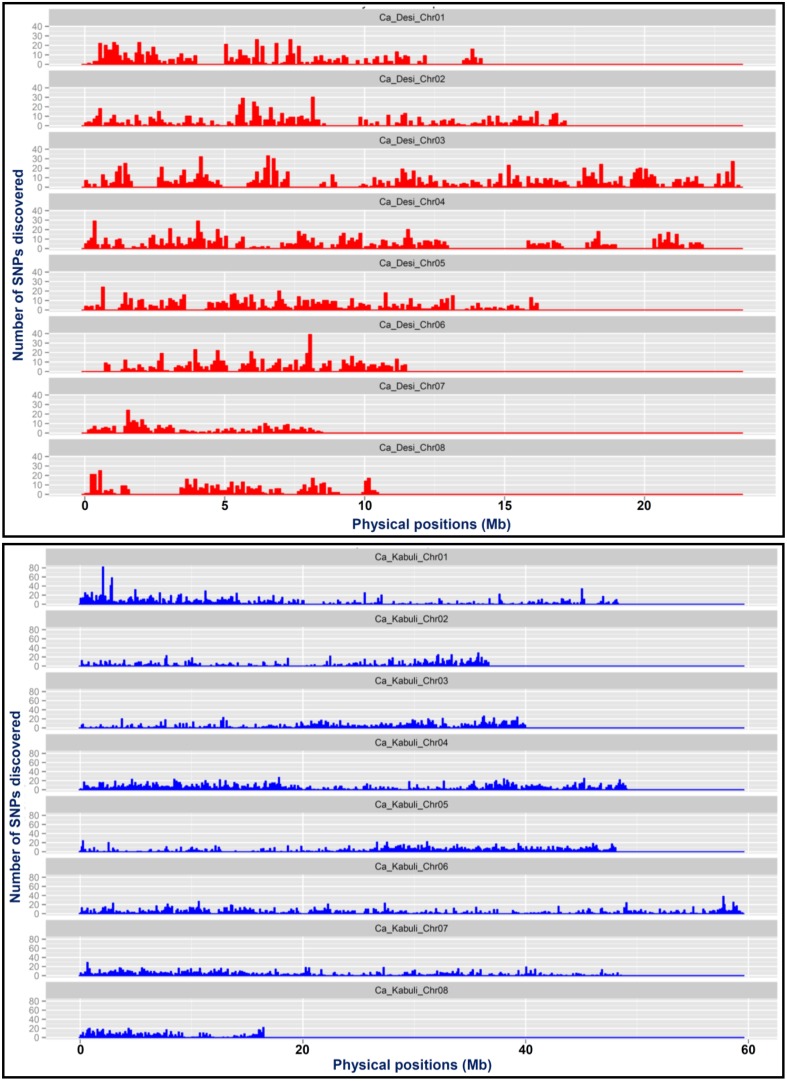
A genome scan plot depicting the density of SNPs physically mapped across eight chromosomes of desi (A) and kabuli (B) genomes at 100-kb sliding window. The SNP density is represented by the number of SNPs mapped within 1-Mb physical intervals across chromosomes.